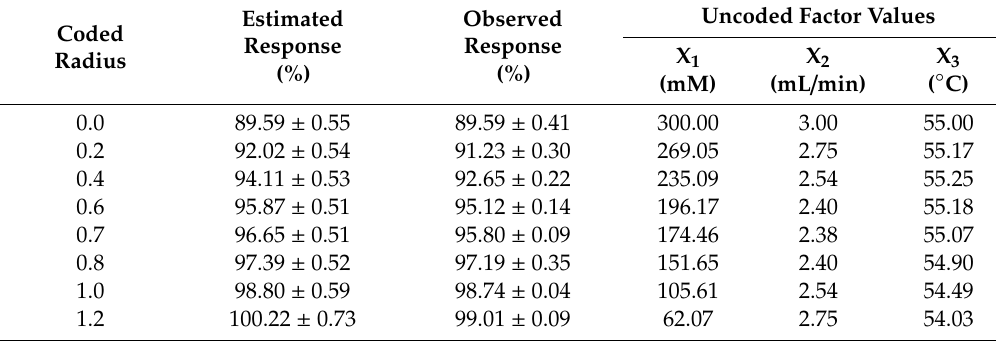
Table 4. The estimated ridge of maximum response for variable production